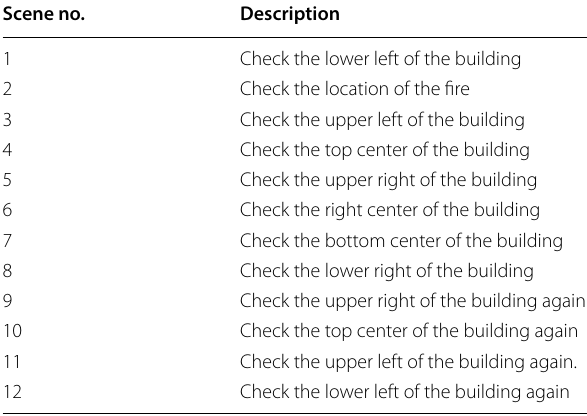
Table 8 Scene description of Fig. 8 Scene no.